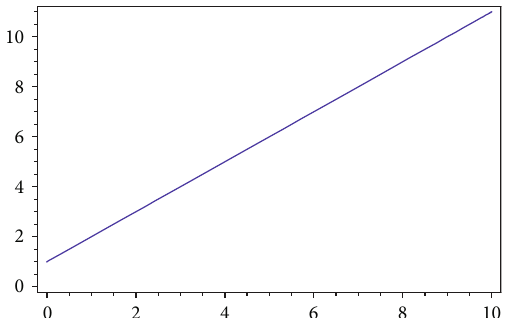
ð m Þ against mass, m c q (cid:1) q